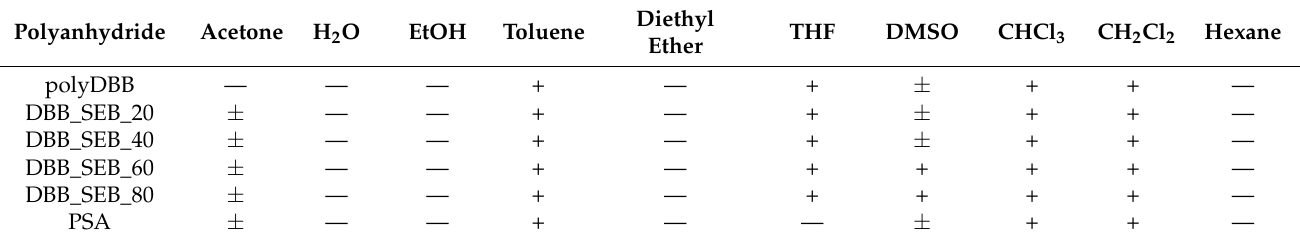
Table 4. Solubilities of DBB- SEB